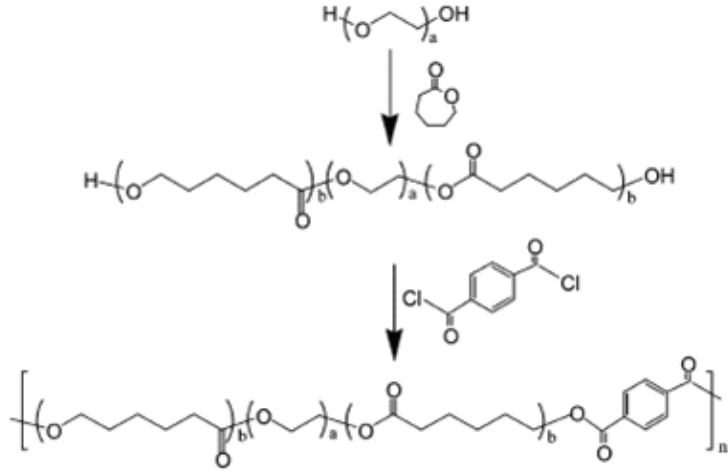
Figure 4. Scheme of the synthesis pathway of the PEG-PCL multiblock copolymer according to reference